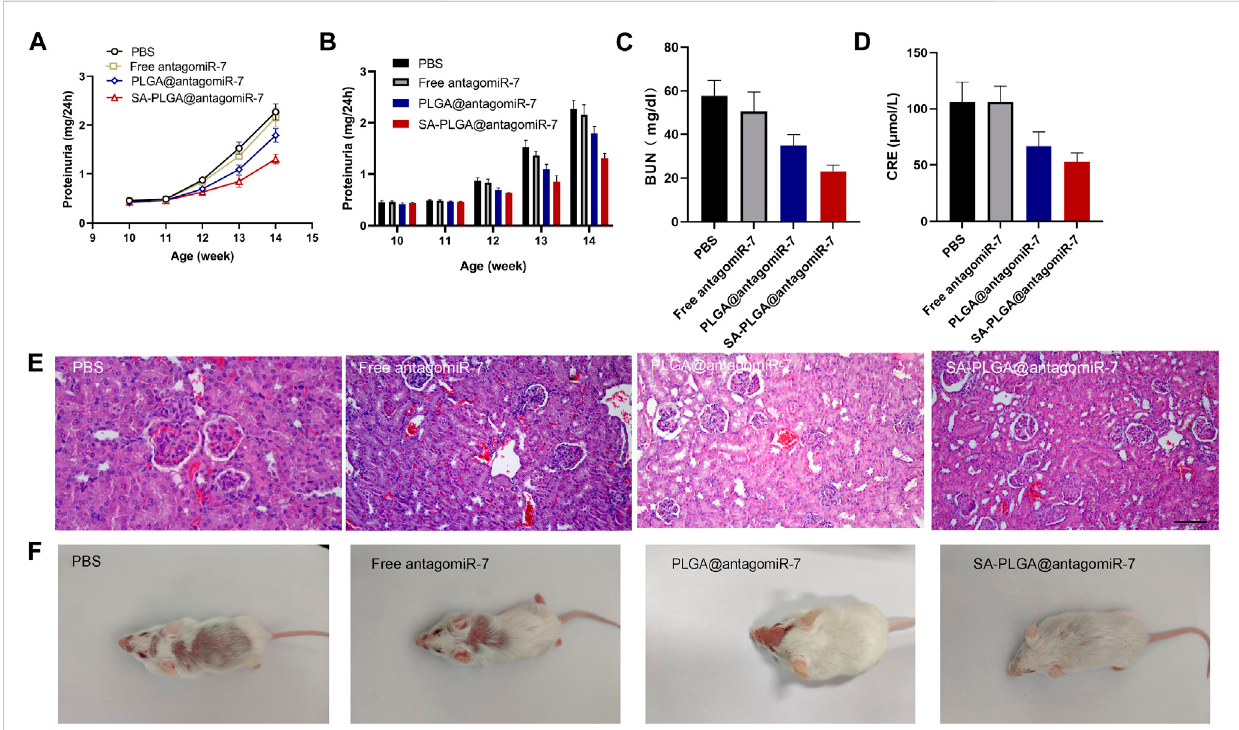
FIGURE 6 (A) Proteinuriawasmeasuredatdifferenttimepoints andstatisticanalysis (B) . (C) SerumBUN levelsinSLEmicetreatedwith